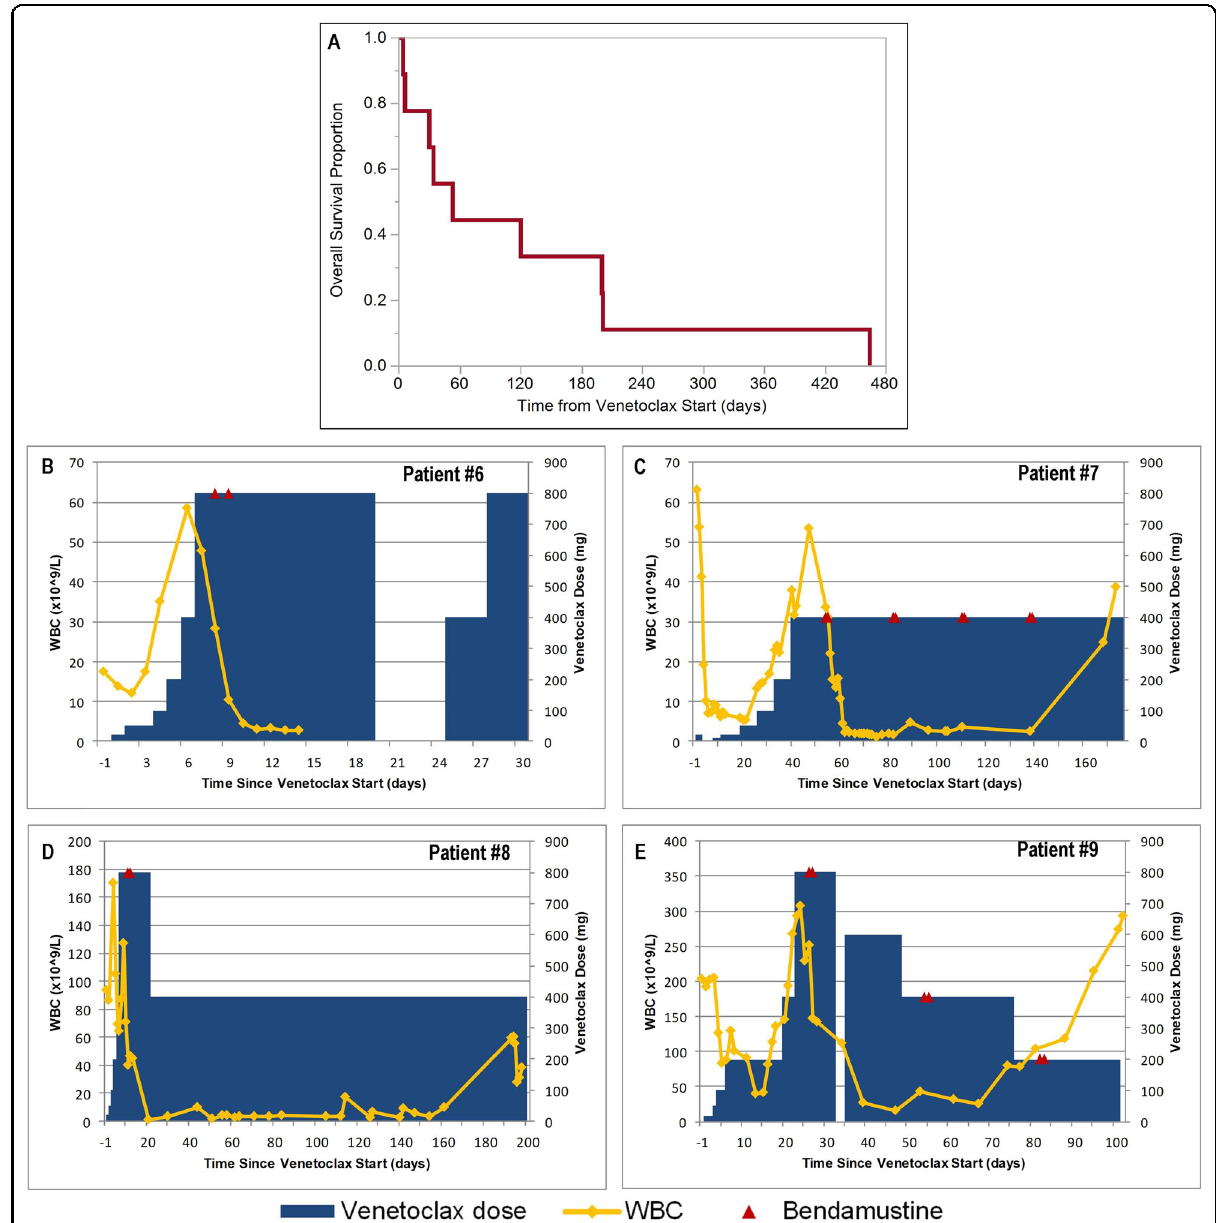
Fig. 1 Survival outcomes and clinical courses with venetoclax treatment. Overall survival of all patients from the start of venetoclax treatment ( A ) White blood cells (WBC) during venetoclax and bendamustine dosing among patients who experienced clinical response ( bottom panels ): Patient #6 ( B ), Patient #7 ( C ), Patient #8 ( D ), Patient #9 ( E